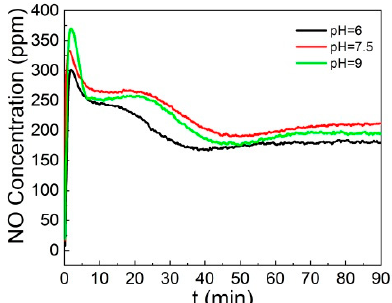
Figure 6. Effect of the initial pH of the NaClO 2 solution on NO removal. Reaction conditions: NaClO 2 concentration 0.008 mol/L; temperature 30 °C; NO inlet concentration 500 ppm; N 2 balance, with a total flow rate of 1.5 L/min.